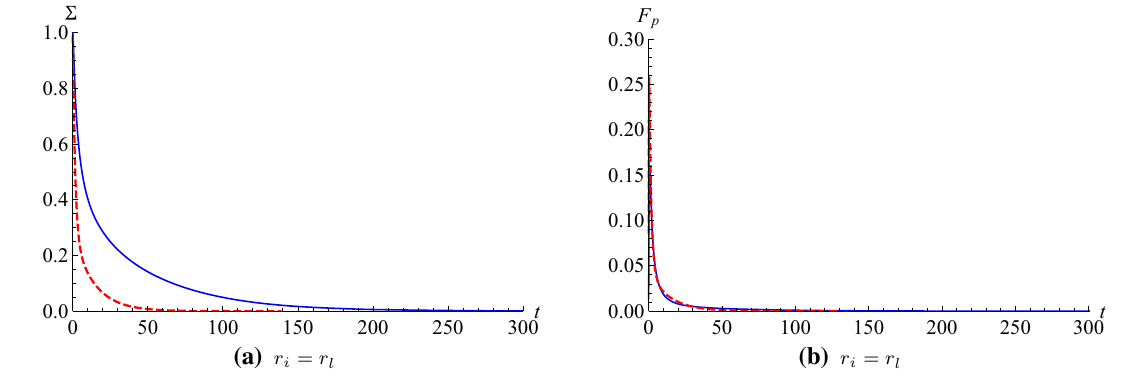
Fig. 8 The pictures of (cid:19) − t and F p − t with the parameters k = 1 , q = 1 , ¯ φ = 10 − 5 . The effective temperature is set to 0 . 995 T c (blue lines) and 0 . 997 T c (dashed red lines),